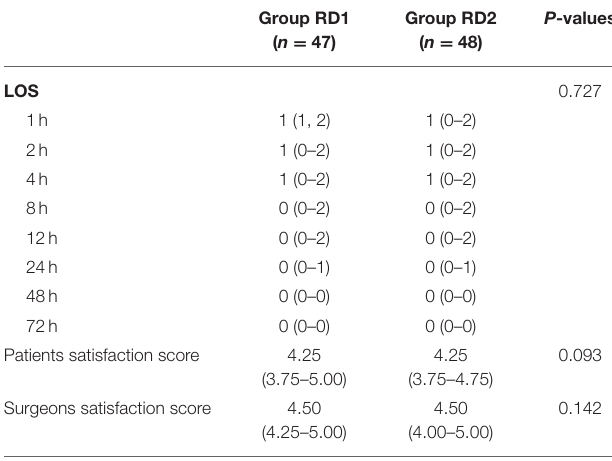
TABLE 4 | Postoperative level of sedation, rescue analgesia, patients, and surgeons satisfaction between the two groups.